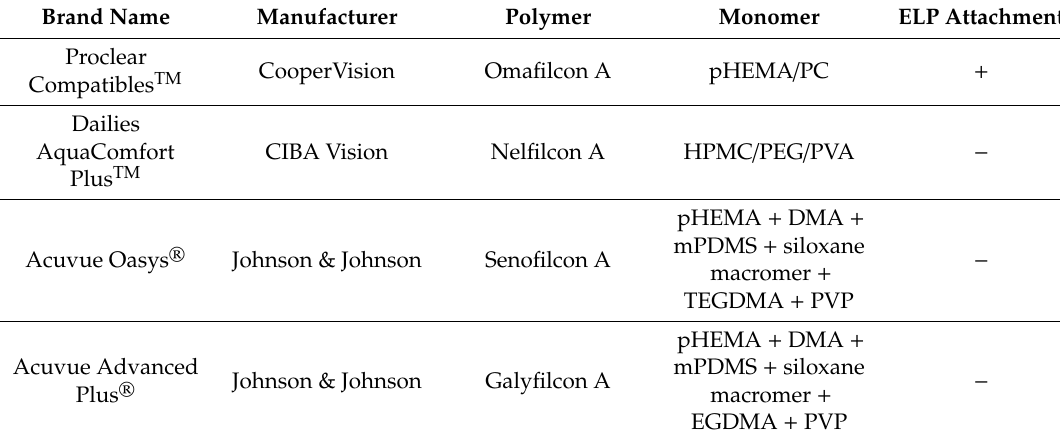
Table 2. Summary of the contact lenses involved in this study.